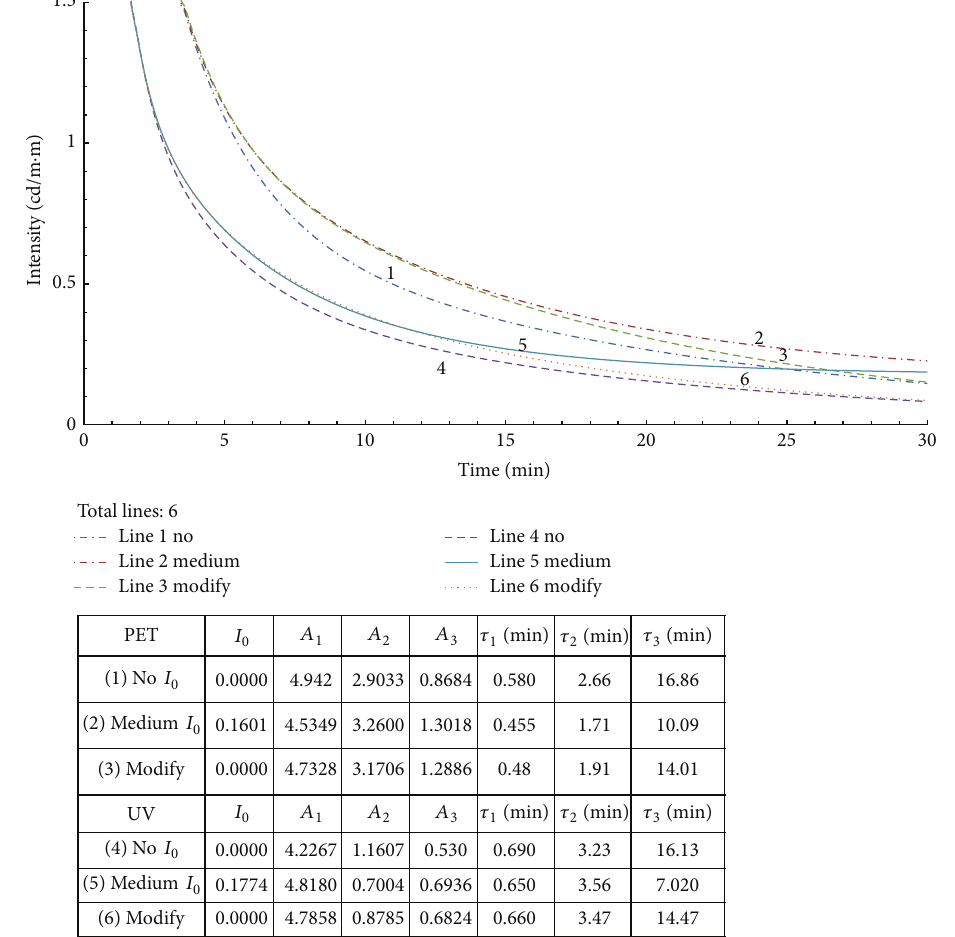
Figure 3: Modified curves with medium 𝑅 values from Figure